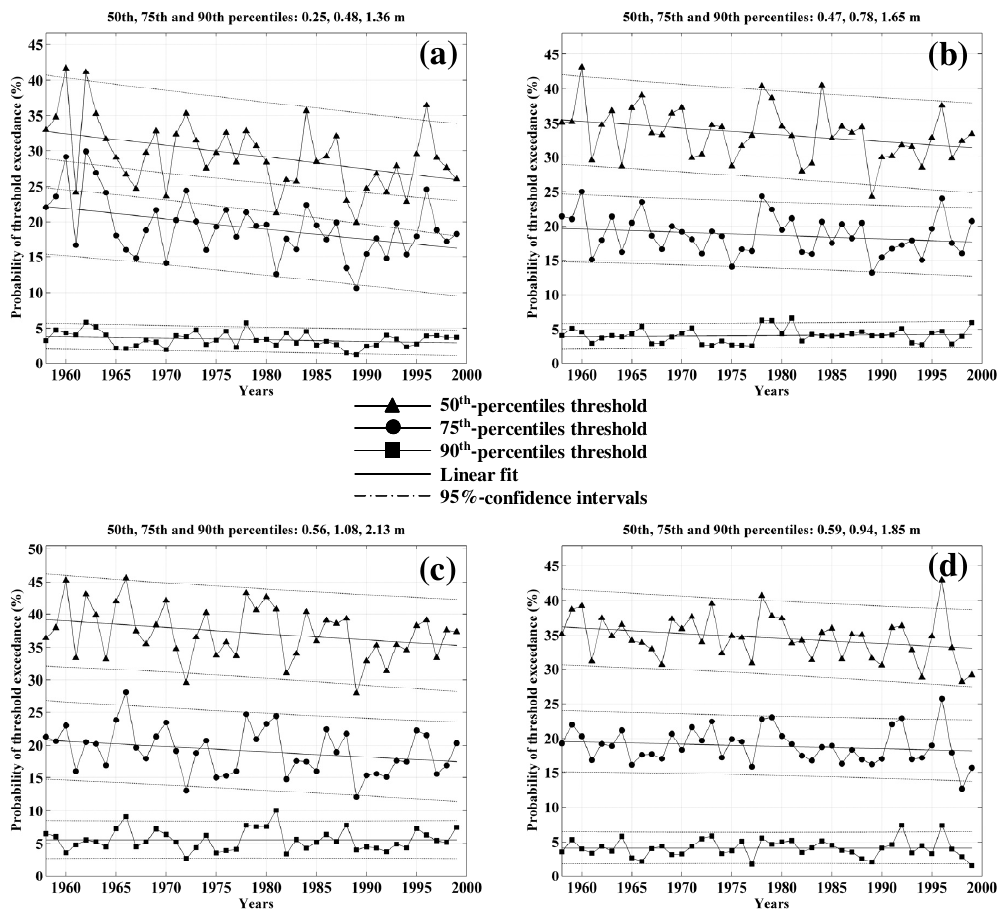
Figure 8. From panel (a) to (d), in the same order as for Figure 3A, are shown the annual averaged H s probabilities of exceeding three different thresholds set at the 50th, 75th and the 90th percentiles of the (ascending) ordered ERA-40 UNILE dataset. Data are linearly fitted in order to highlight trends.